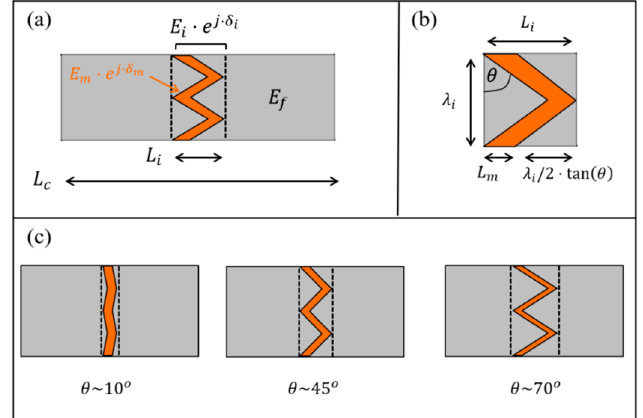
Figure 4. Schematic descriptions of zigzag-shaped sutural interfaces in biocomposites and their geometrical parameters. ( a ) A biocomposite segment with an underlying sutural interface. ( b ) An isolated interfacial region (one period) from the biocomposite. ( c ) Schematic examples of sutural interfaces with the same matrix length ( L m ), but different zigzag angles ( θ = 10 ◦ , 45 ◦ , and ∼ 70 ◦ ).